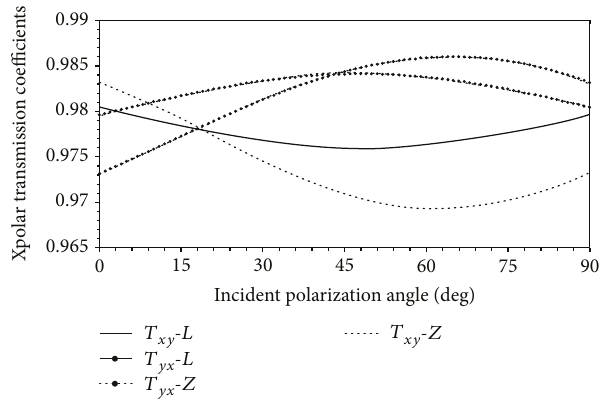
Figure 7: Cross-polar transmission coe ffi cients of the proposed 4- layered perfect LP converter devices versus direction of incident wave polarization at resonance frequency.